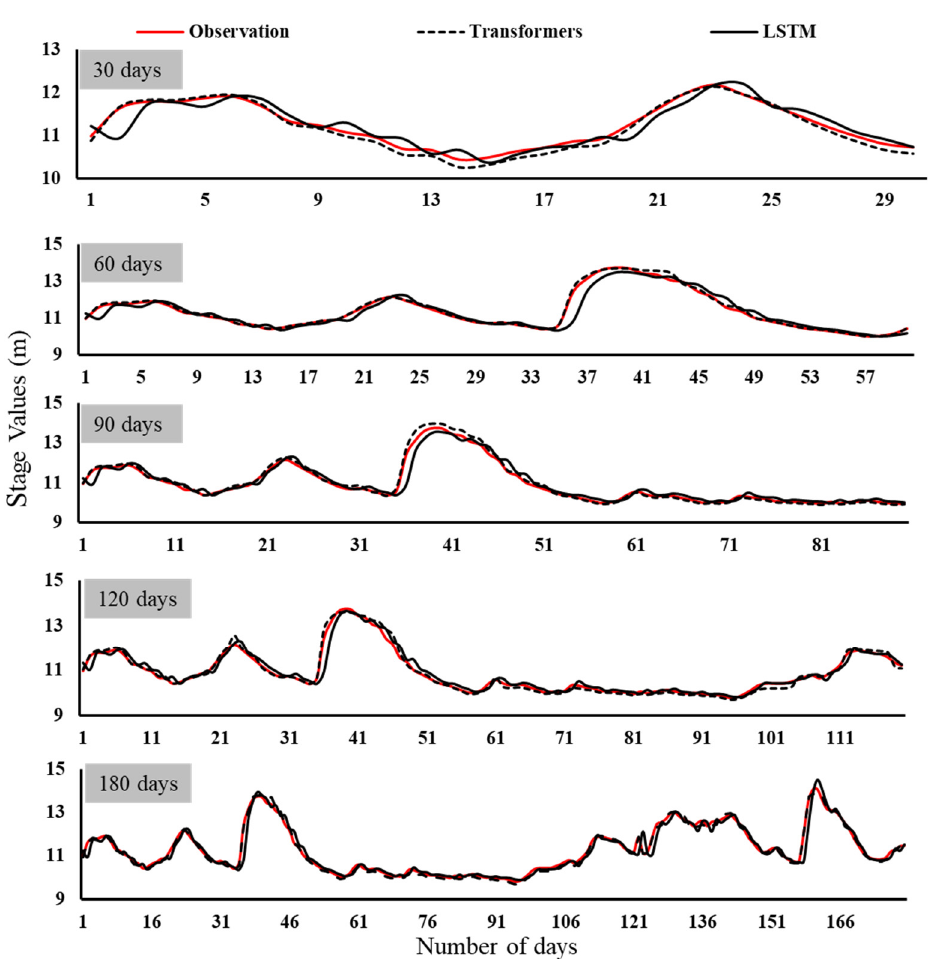
Figure 5. Results of DL models vs, different future forecasted stage data for Blountstown station. Table 2. Performance of transformer and LSTM models for stage-level (m)